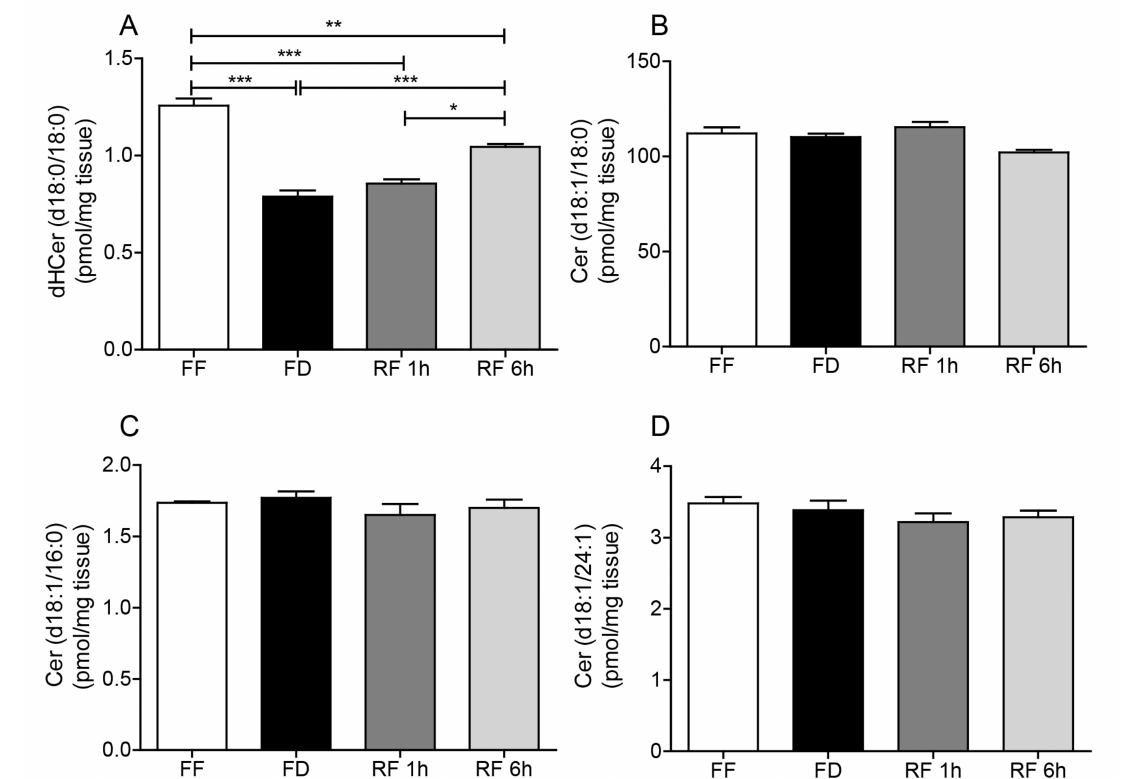
Figure 3. E ff ects of feeding status on ( A ) dihydroceramide (d18:0 / 18:0), ( B ) ceramide (d18:1 / 18:0), ( C ) ceramide (d18:1 / 16:0) and ( D ) ceramide (d18:1 / 24:1) in mouse hypothalamus. Free feeding (FF), 12 h food deprivation (FD), 1 h refeeding after FD (RF 1h) and 6 h refeeding after FD (RF 6h). Results are expressed as mean ± SEM ( n = 5–10 / feeding condition). * p < 0.05, ** p < 0.01, *** p < 0.001; one-way ANOVA followed by Tukey’s multiple comparison test. E ff ects of feeding status on ceramide (d18:1 / 20:0), ceramide (d18:1 / 22:0), ceramide (d18:1 / 24:0), dihydroceramide (d18:0 / 16:0), dihydroceramide (d18:0 / 24:0), dihydroceramide (d18:0 / 24:1) in mouse hypothalamus.